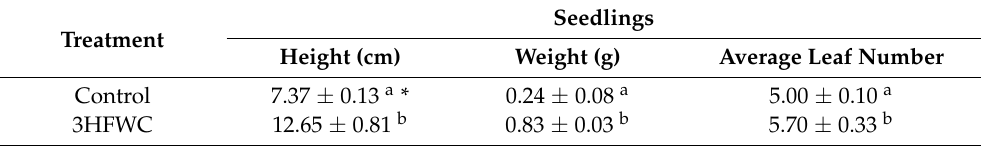
* The data represented in table are mean value ± standard error. Mean values within the same column marked with different letters are statistically different according to Fisher’s LSD test ( p ≤